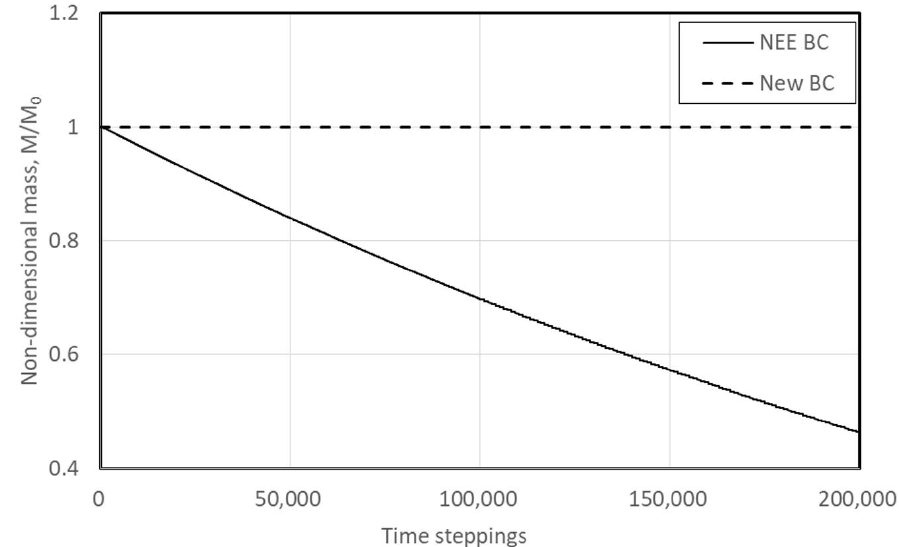
Figure 10. Variation of non-dimensional mass against time step using the newly developed mass-conserved and NEE boundary conditions for a multiple right bending pipe.